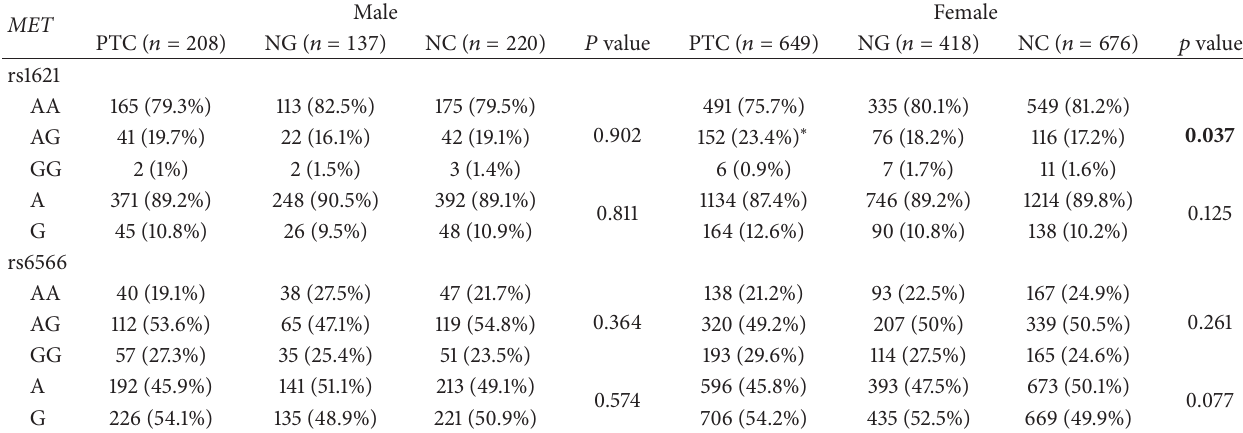
Table 2: Association between MET SNPs (rs1621 and rs6566) and thyroid tumors as stratified by the gender. MET